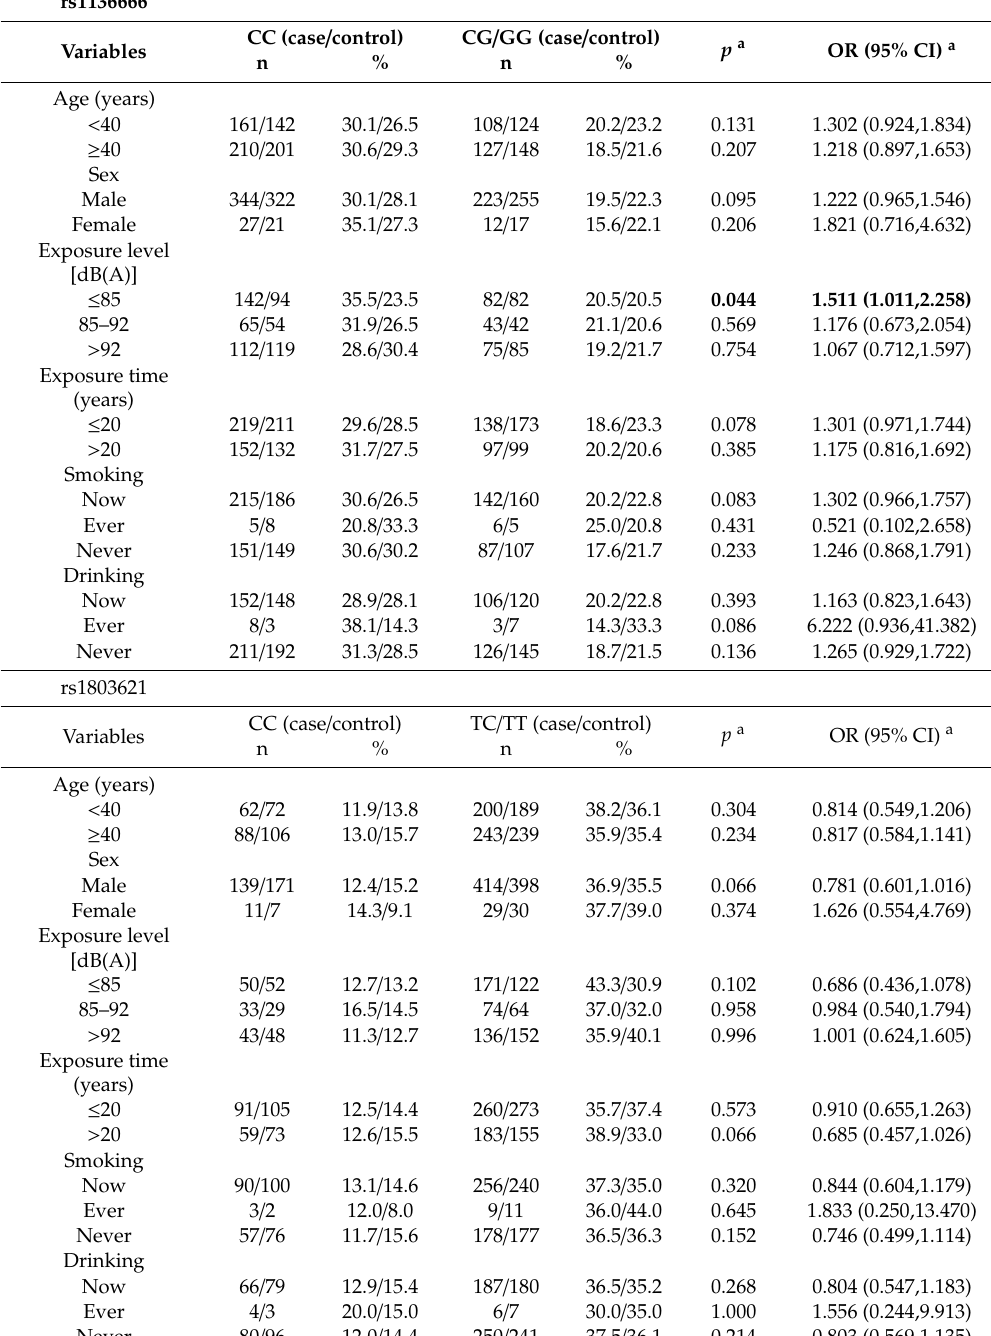
Table 5. Stratified analyses of SNPs in a dominant